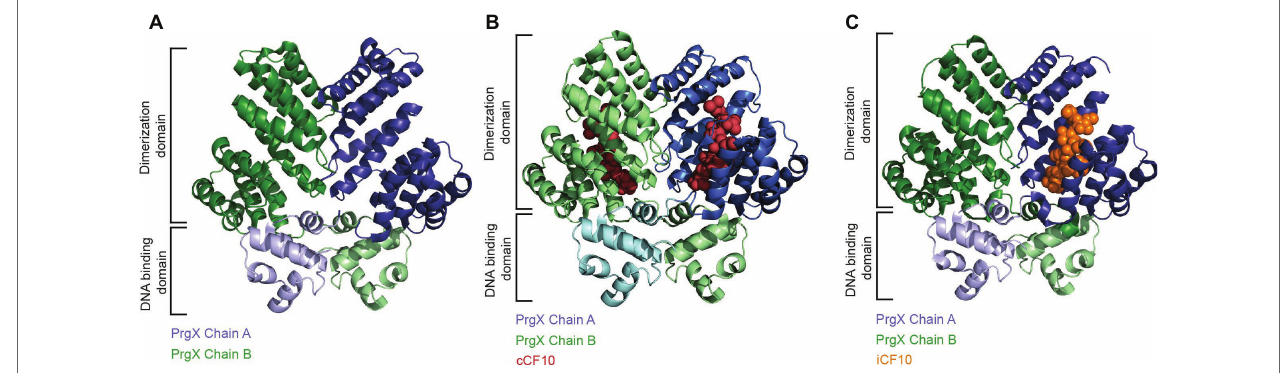
FIGURE 3 | Structural basis for the regulation of the P Q promoter. (A) The PrgX protein forms tetramers, which repress transfer gene expression by binding to two adjacent operator sites, one of which overlaps with the P Q promoter. The tetramer is built as a dimer of dimers with each dimer occupying one operator site with the N-terminal DNA-binding domain, whereas the C-terminal domain accommodates the dimerization and pheromone-binding function. The dimer of apo-PrgX (PDB: 2AXU) is shown in a cartoon presentation with the chains colored in blue and green, respectively. (B) Binding of the pheromone cCF10 (red spheres) leads to a conformational change in the C-terminal region of PrgX (PDB: 2AXZ), alleviating the repression of the P Q promoter. (C) A surplus of iCF10 (orange spheres), which competes with cCF10 for the same binding site (PDB: 2GRL), reinstates the repressed state of the P Q